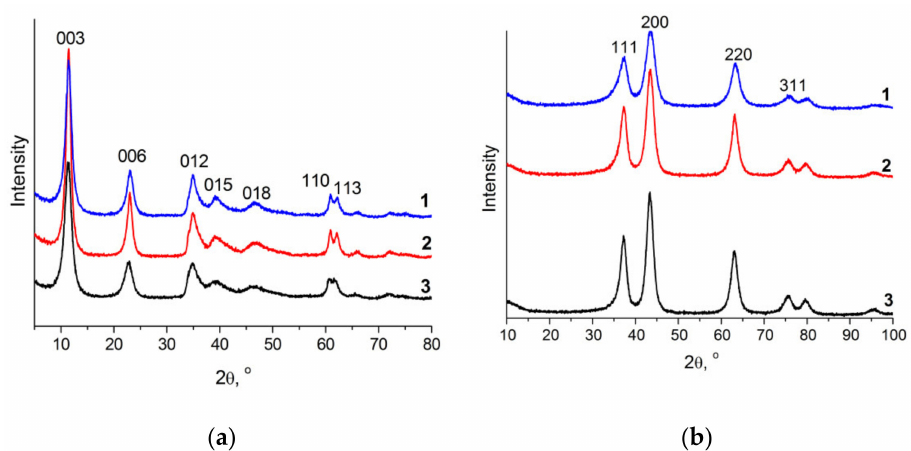
Figure 1. Diffraction patterns of NiAl LDH samples in the carbonate form ( a ) and the corresponding oxide phases ( b ) with the Ni/Al atomic ratio of 2 (line 1), 3 (line 2), and 4 (line 3).